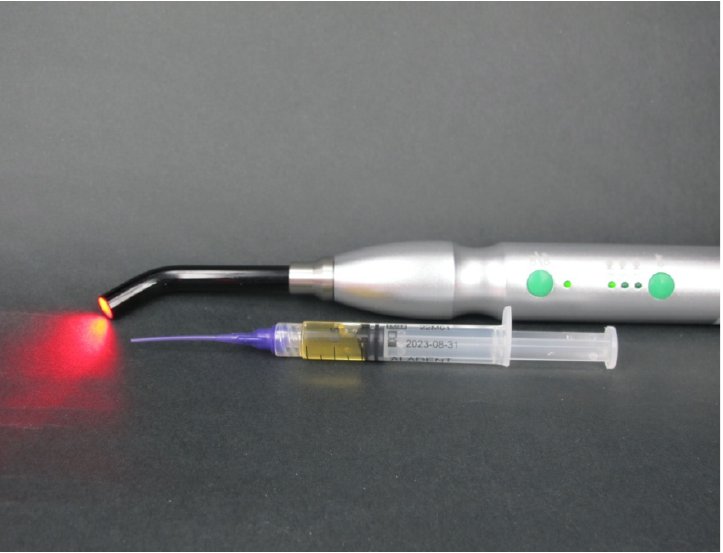
Figure 1. Aladent thermosetting gel and TL-01 630 nm led activator.